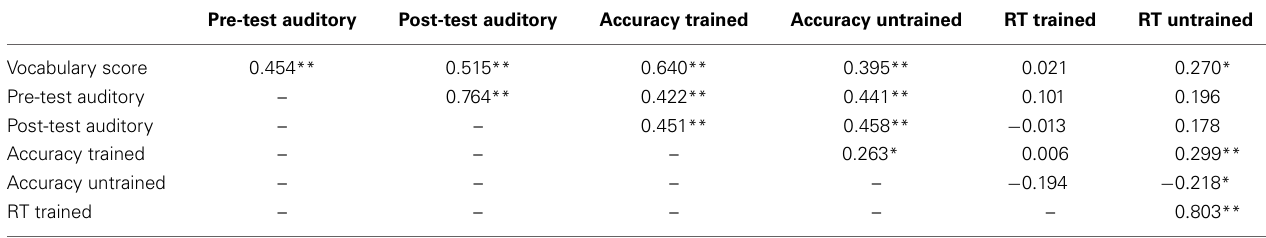
Table 4 | Correlation coefficients among the vocabulary scores, response times (RT trained, RT untrained) and accuracy scores for the auditory identification scores (Accuracy trained, Accuracy untrained) and the pre- and post-test auditory generalization scores (Pre-test auditory, Post-test